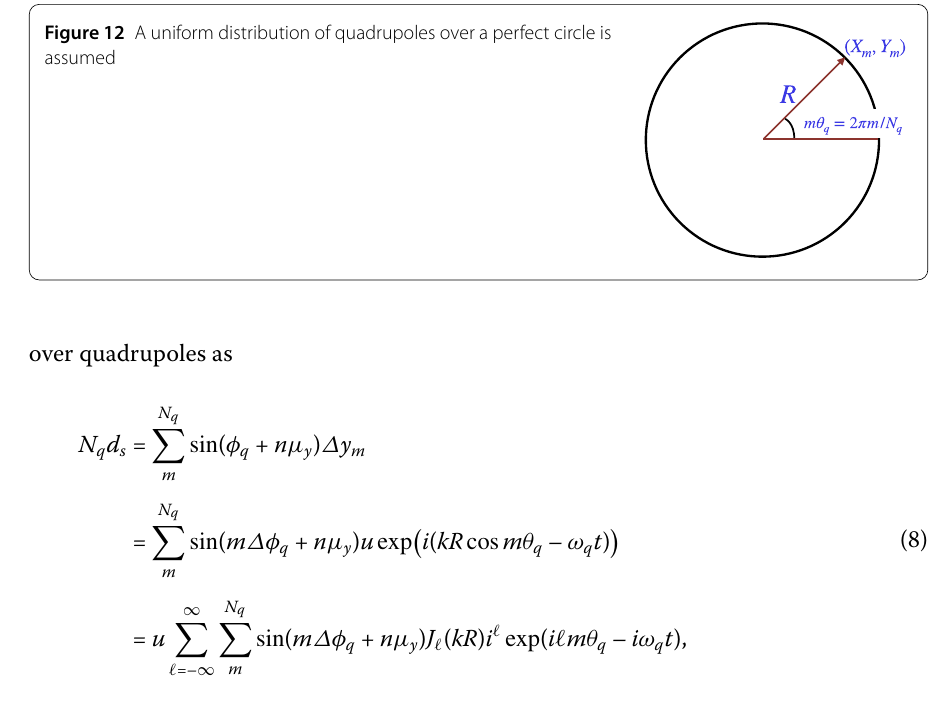
Figure 12 A uniform distribution of quadrupoles over a perfect circle is assumed